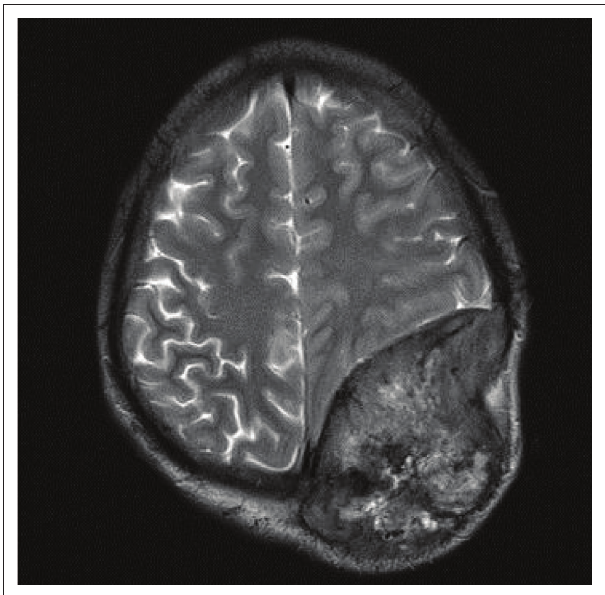
FIGURE 4: Axial T2-weighted MR image showing the mass with lack of edema in adjacent brain parenchyma.